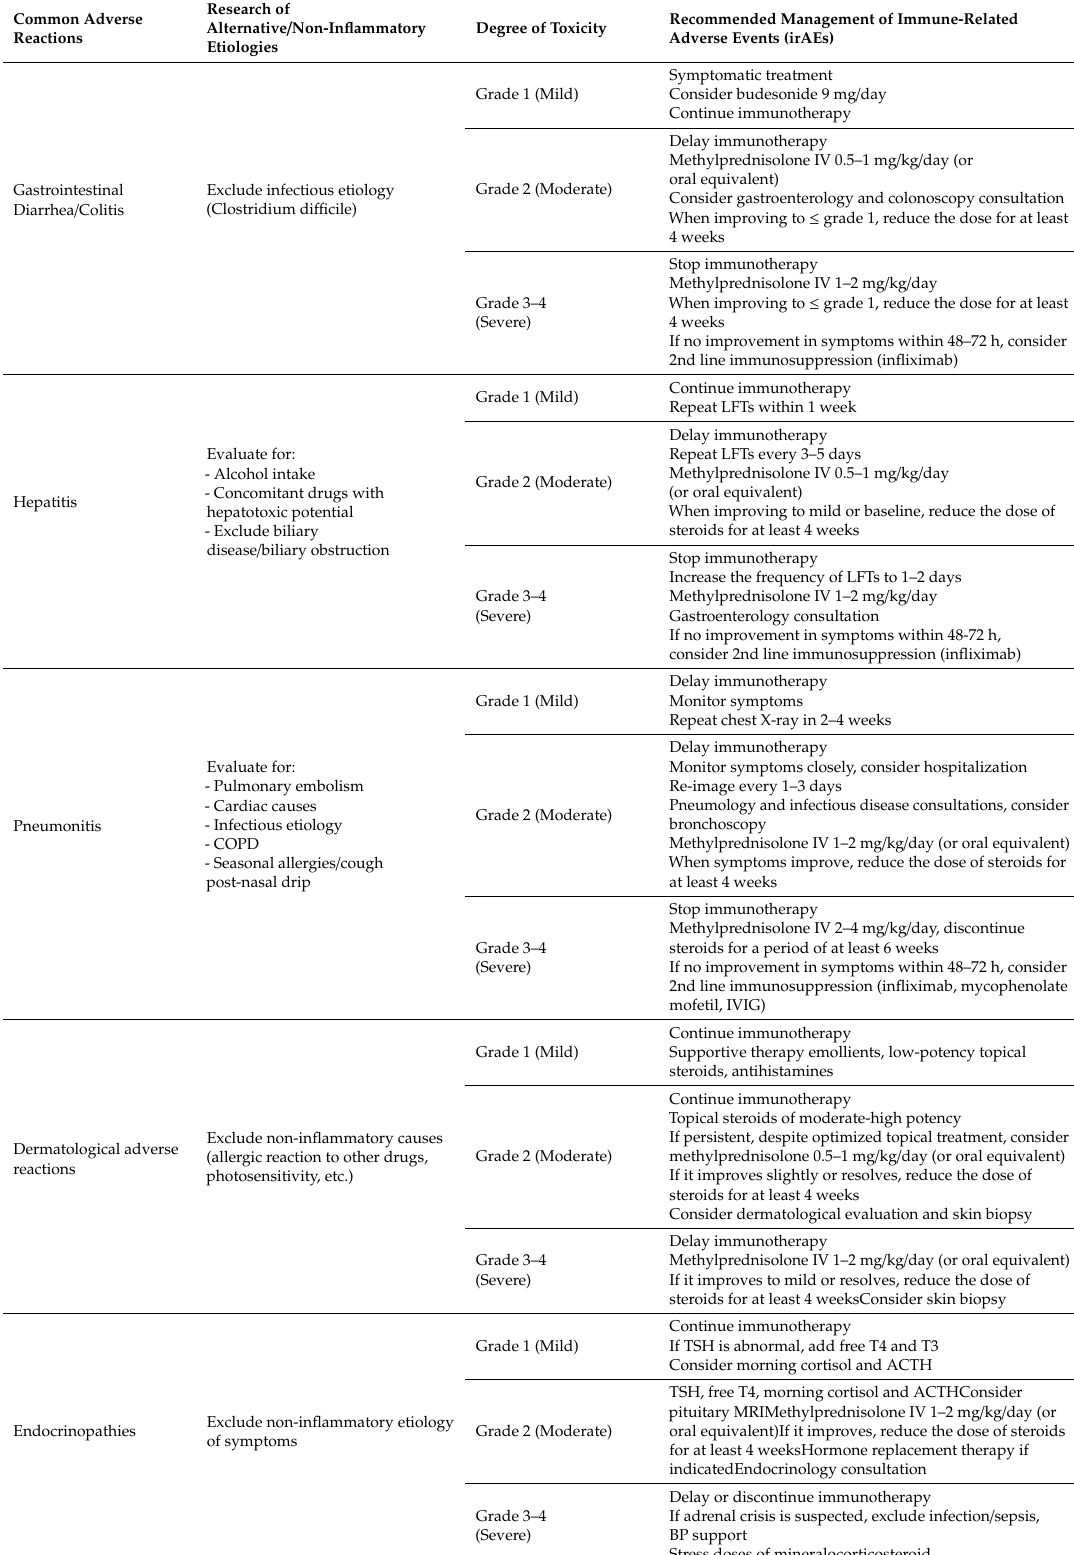
Table 4. Recommendations for the treatment of the main adverse reactions, related to the immune system, associated with ICPI (adapted from ref.